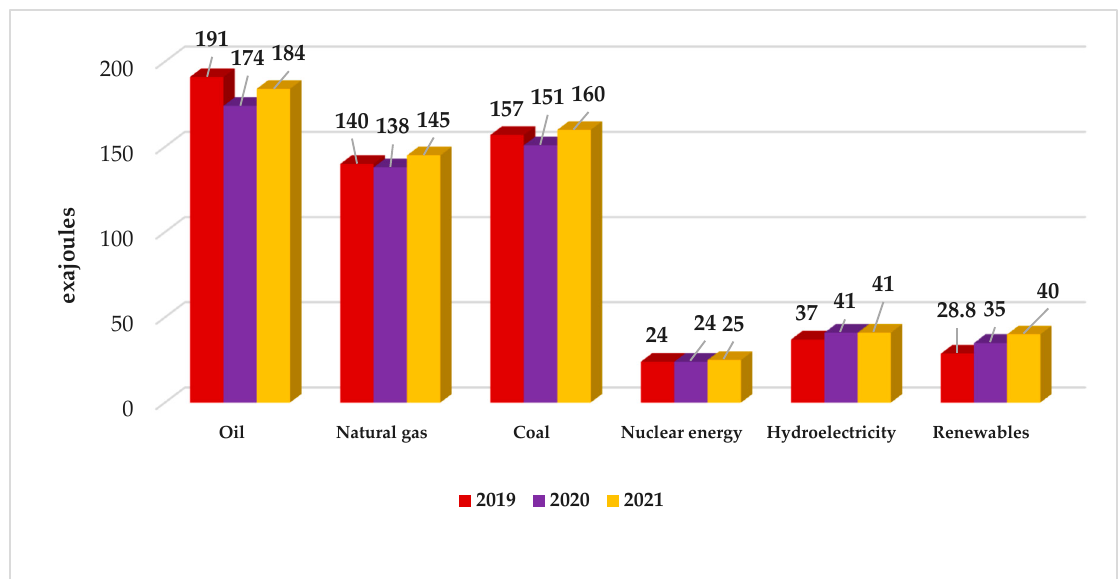
Figure 1. Consumption of energy worldwide by energy fuel type [57].